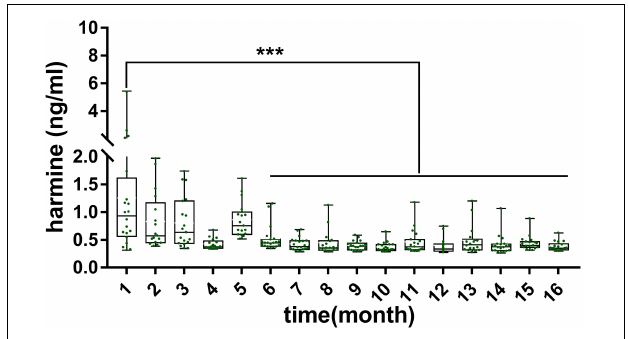
FIGURE 2 | Concentration of harmine in rat plasma and various tissues during the development of pup rats. Significant difference: *** P <